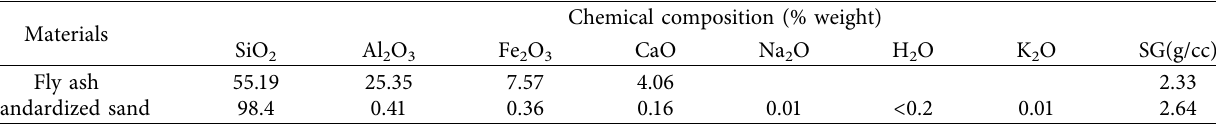
Table 1: Specific gravity (S.G.), the chemical composition of materials in weight percentage (wt%) by XRF, and chemical analysis of standardized sand.